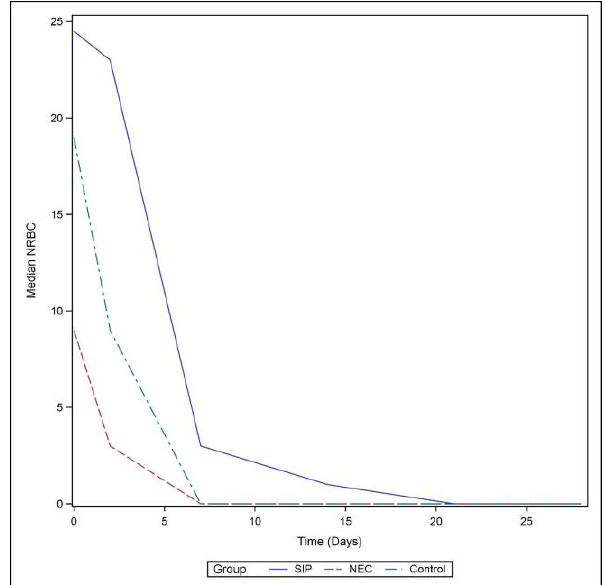
Figure 3: Median NRBC by the group over time